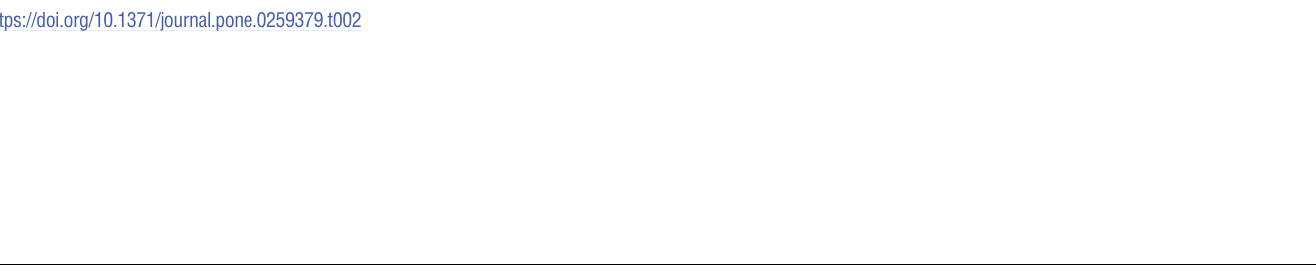
† Indicates species that have been submitted to the IUCN Red List but have not yet been published. Categories and criteria for these species are thus considered pending until formal